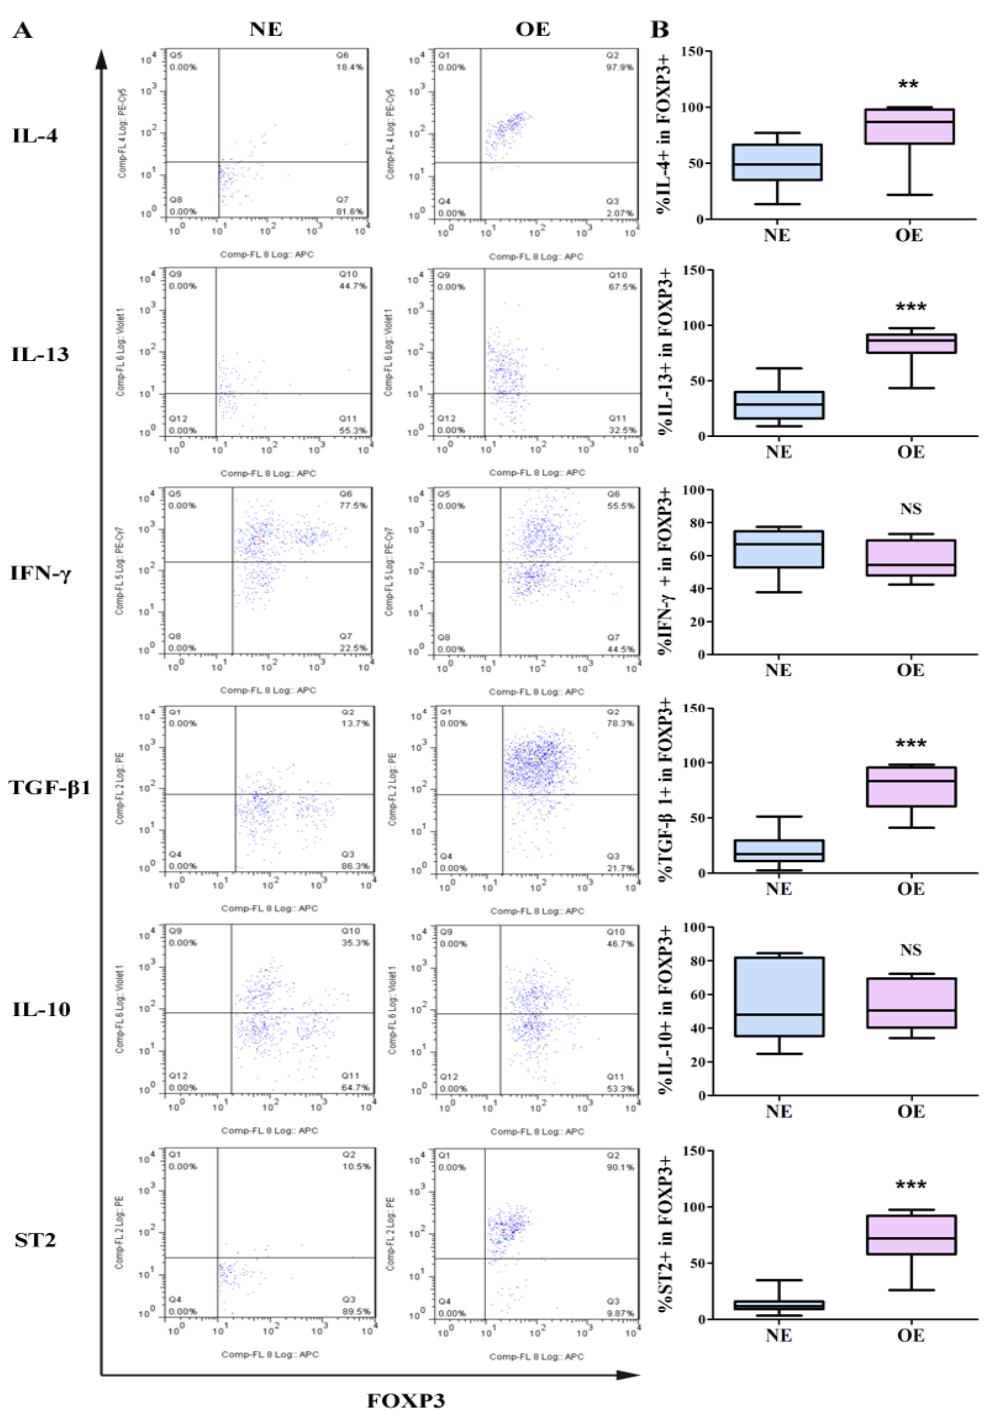
Figure 1. Flow cytometry results of cytokines and ST2 expressed by Tregs in ovarian endometrioma and normal endometrium. Lymphocytes extracted from ovarian endometrioma (OE) and normal endometrium were stimulated with PMA and ionomycin and stained for CD4, CD25, FOXP3, IL-4, IL-13, IFN- γ , TGF- β 1, IL-10, and ST2. ( A ). Representative flow cytometry images comparing the proportion of cytokine-producing Tregs. ( B ). Cumulative data comparing the proportion of cytokine-producing Tregs. For IL-4 and IL-13, n = 16 control subjects and n = 11 OE patients. For TGF- β 1, n = 17 for control subjects and n = 12 for OE patients. For IFN- γ , n = 10 control subjects and n = 8 OE patients. For ST2, n = 16 control subjects and n = 11 OE patients. NS: not significant; **: p < 0.01; ***: p < 0.001. Abbreviations used: NE: normal endometrium; OE: ovarian endometrioma.